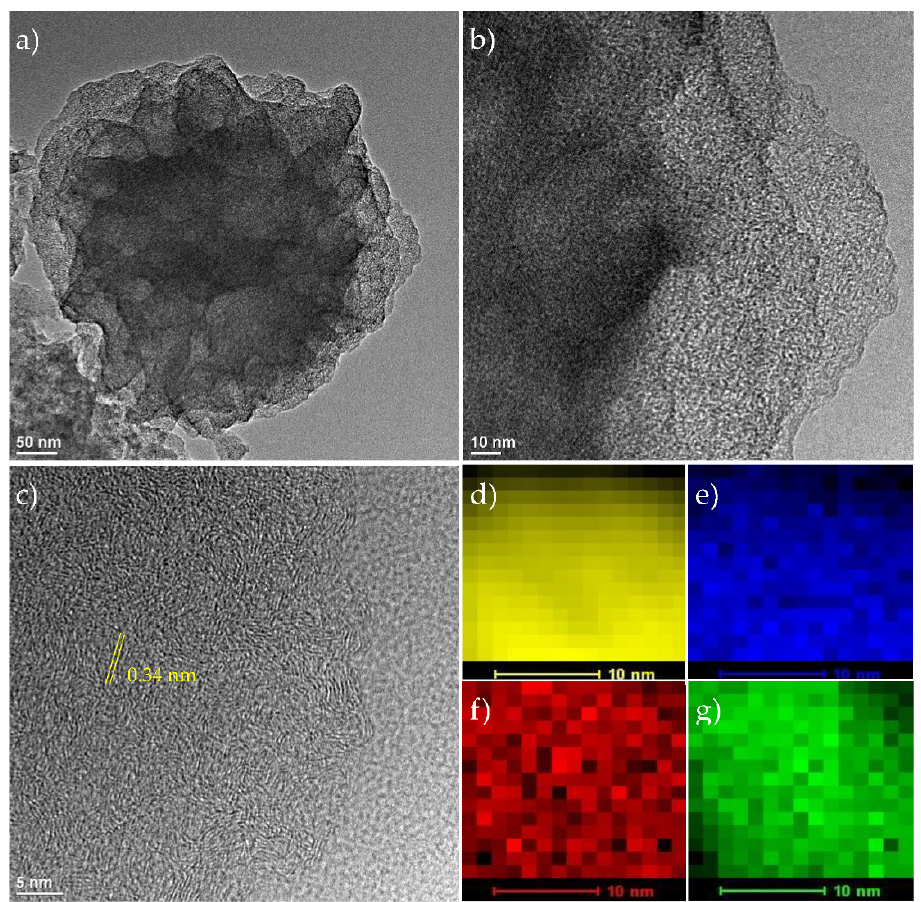
Figure 1. ( a – c ) TEM images of FeNi-NCF(3) at different magnifications, along with the associated elemental maps of ( d ) C, ( e ) N, ( f ) Fe, and ( g ) Ni. The sample porosity was then examined by nitrogen sorption measurements (Figure